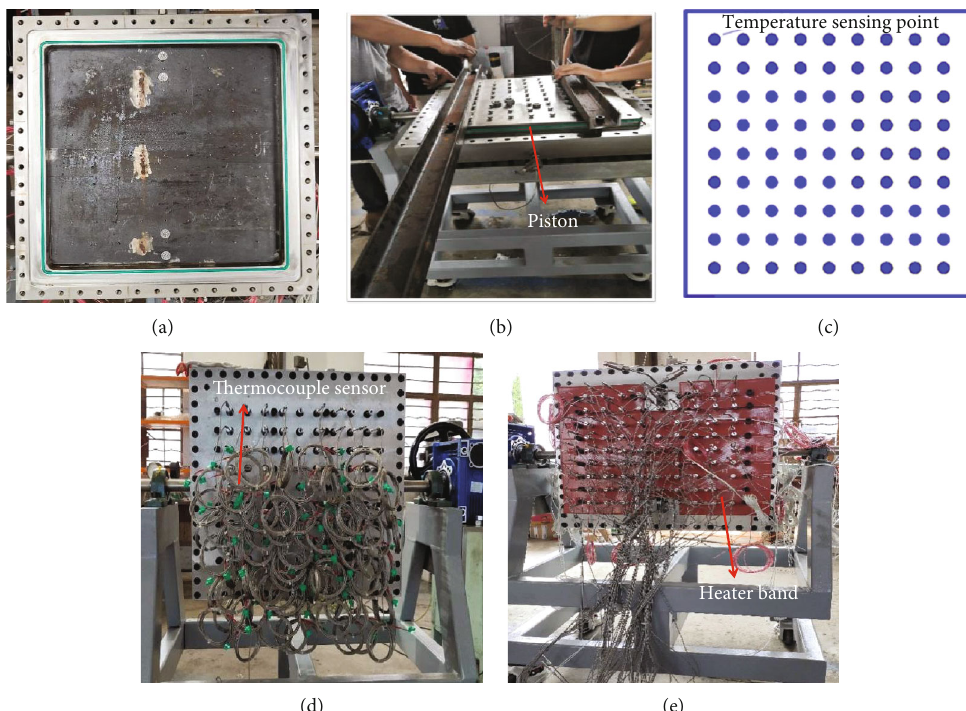
Figure 6: The 2D visualization device. (a) Internal structure. (b) Piston on the back of model. (c) Distribution of temperature sensing points. (d) Thermocouple sensors. (e) Heater bands.